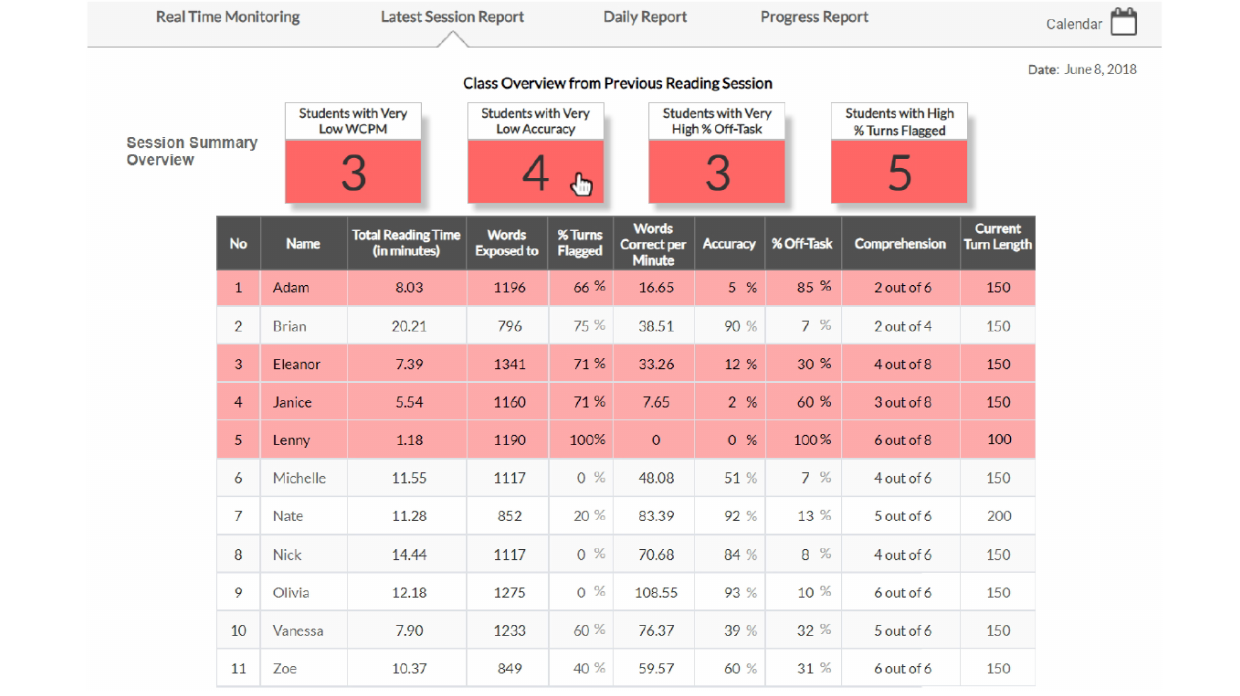
FIGURE 2 | Class roster view with fluency, accuracy and comprehension for each student at the end of a reading session (from Kannan et al., 2019). This teacher-facing dashboard shows the detailed class roster at the end of a reading session. It provides metrics on a number of variables (such as fluency, accuracy, and comprehension evaluated using factual questions based on material just read) that would be immediately useful and actionable for the teacher. In addition, important variables are also highlighted using cards on the top of the screen and when the teacher clicks on these cards (e.g., students with low accuracy has been clicked in this snapshot), those students are highlighted in the